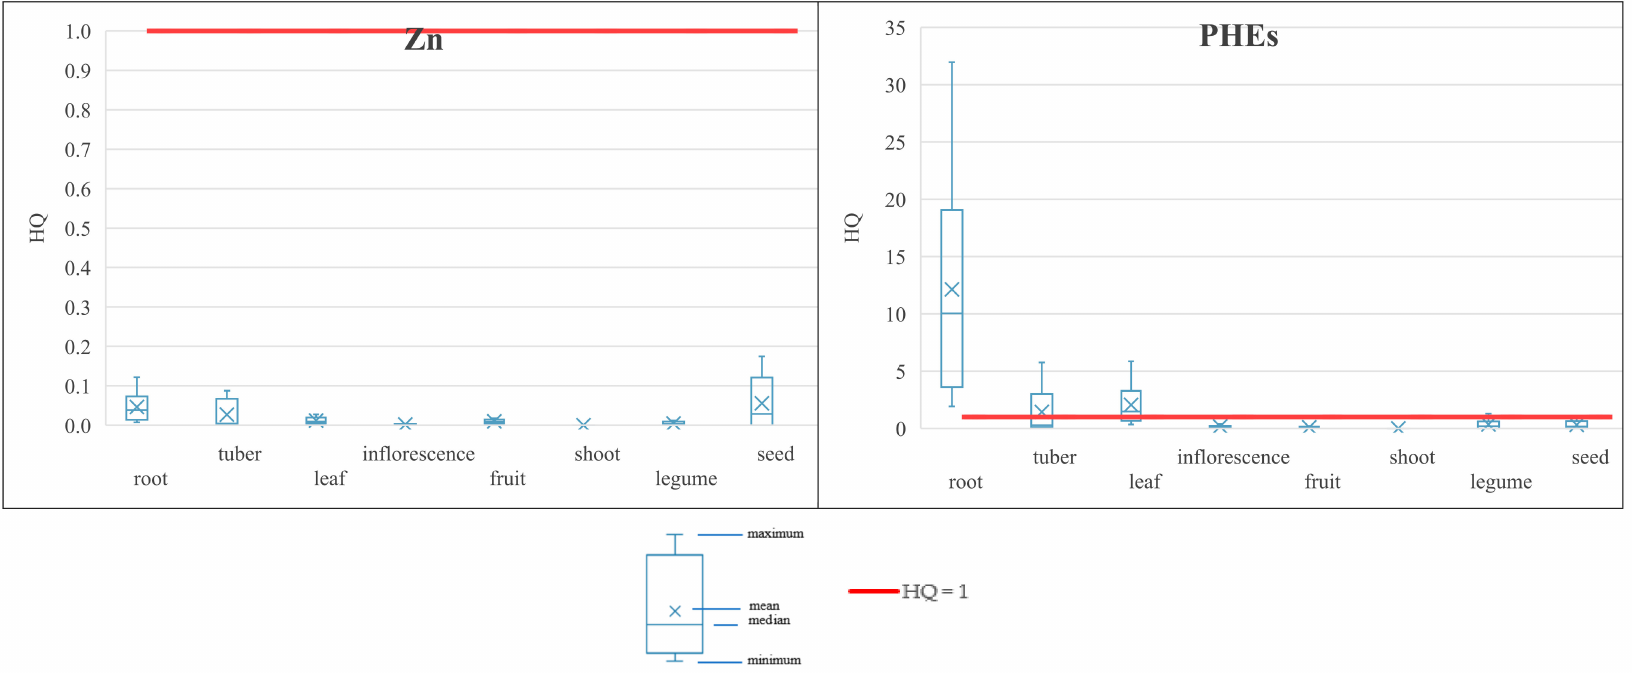
Figure 3. The HQ values of PHEs caused by vegetable